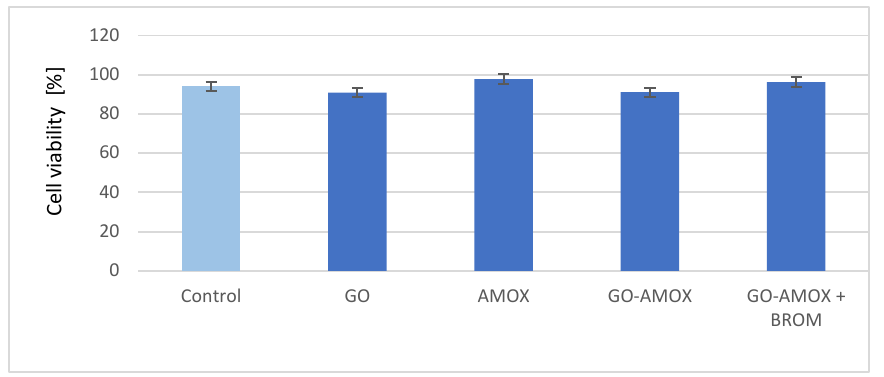
Figure 8. Mice fibrosarcoma WEHI 164 cells viability in the presence of GO (1 mg GO /mL), AMOX solution (180 μg/mL), GO-AMOX (1 mg GO /mL, m AMOX /m GO = 0.18), GO-AMOX and the enzyme (BROM) solution (0.1 mg GO /mL, m AMOX /m GO = 0.18, C E = 0.2 mg/mL). Control—the cells growth without any additions.